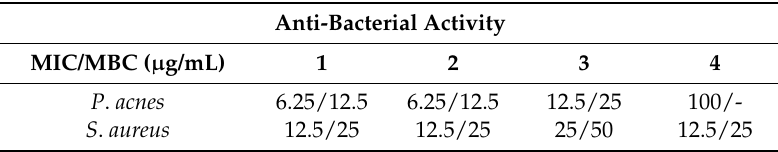
Table 3. Anti- P . acnes and S . aureus effects of pomegranate extract